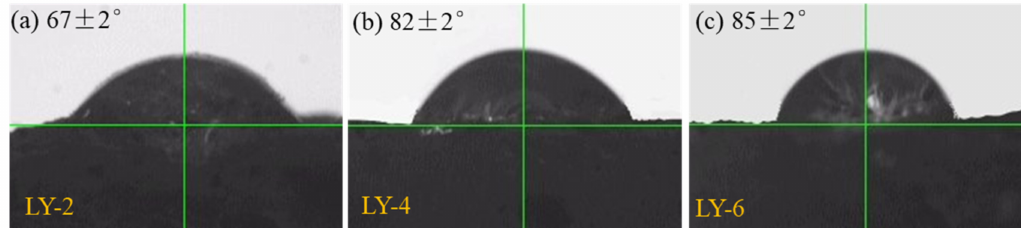
Figure 3. Contact angles of concrete at 28 days: ( a ) LY-2; ( b ) LY-4; ( c )